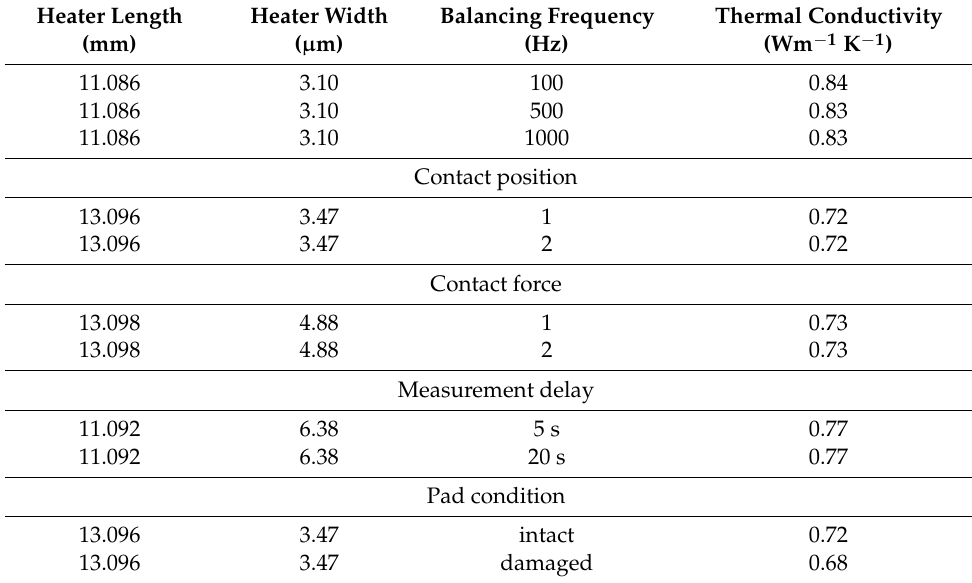
Table 4. Results for different potential measurement influences for a 1 µm thin SiO 2 thin film. The deployed heater geometry, investigated parameters, and measurement results are shown.